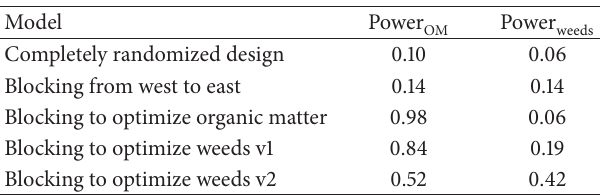
Table 3: Power to detect a 5 percent difference for organic matter and a 10 percent difference for total weeds for a completely randomized design and 4 different blocking scenarios. 𝛼 = 0.05, number of groups = 6, 𝑛 =